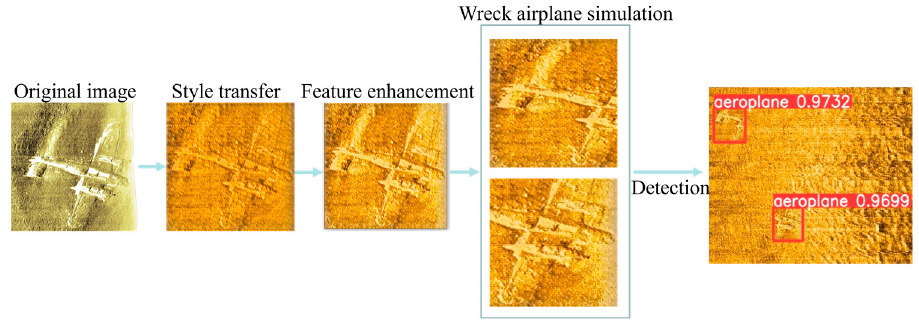
Figure 19. Wreckage simulation process and detection result.